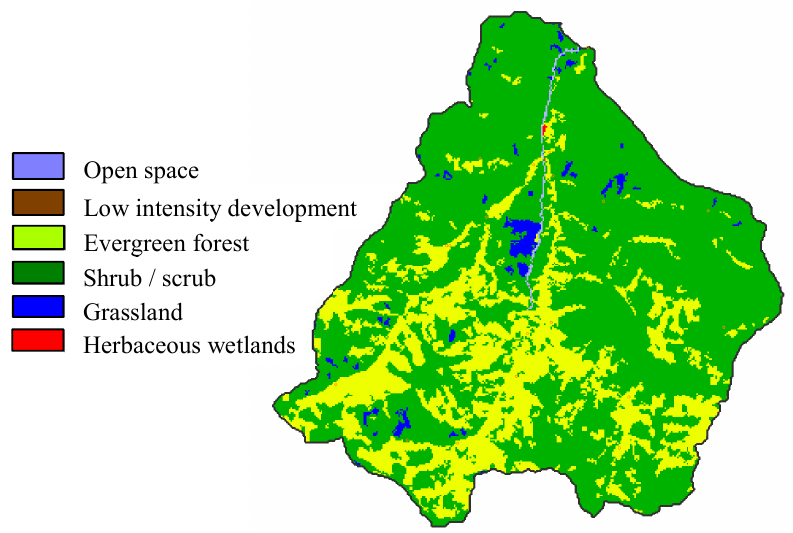
Figure 7. Land cover types in the study area.